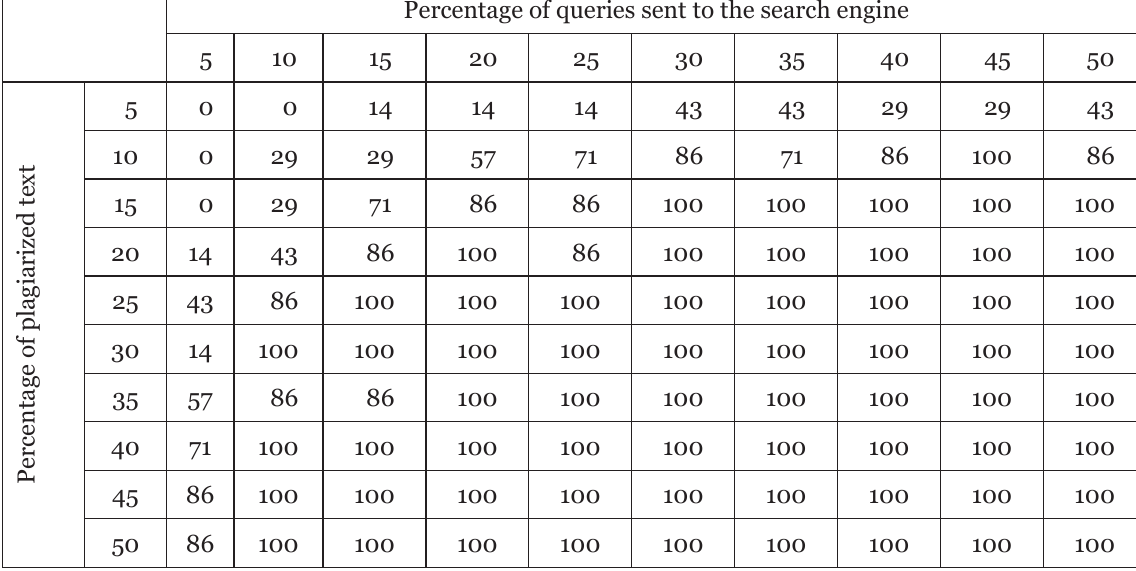
Plagiarism Detection Results in the General Objects Category Percentage of queries sent to the search